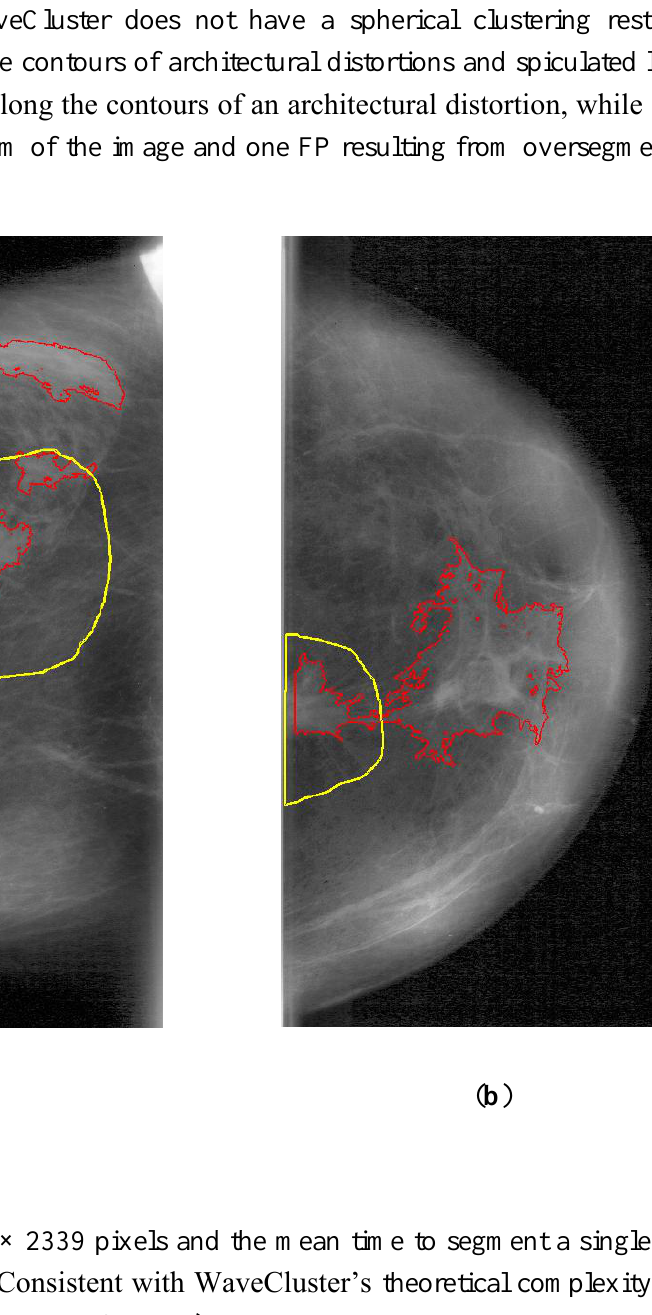
Figure 4. Example false positive WaveCluster results overlaid on original images in red, ground truth in yellow. WaveCluster does not have a spherical clustering restriction; consequently, it can follow the contours of architectural distortions and spiculated lesions.